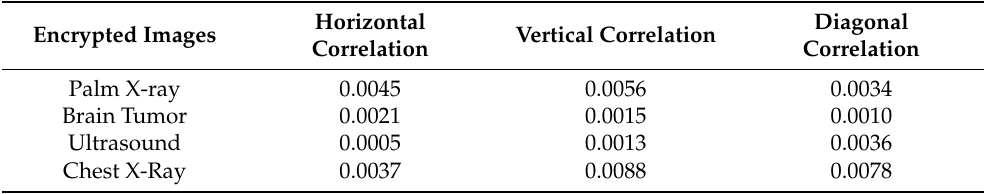
Table 4. Correlation coefficient of the encrypted medical